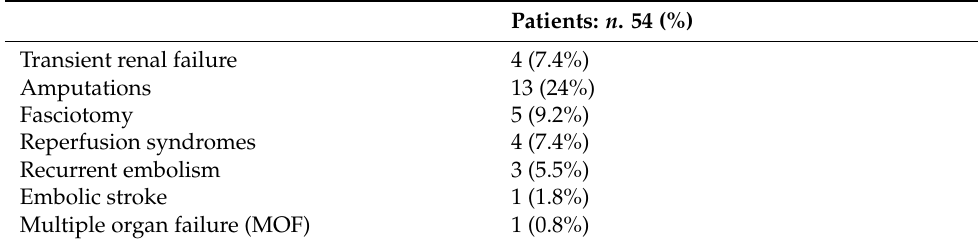
Figure 3. CTA scan revealed unstable thoracic aortic thrombus. Table 4. Table 1. Characteristics of patients.